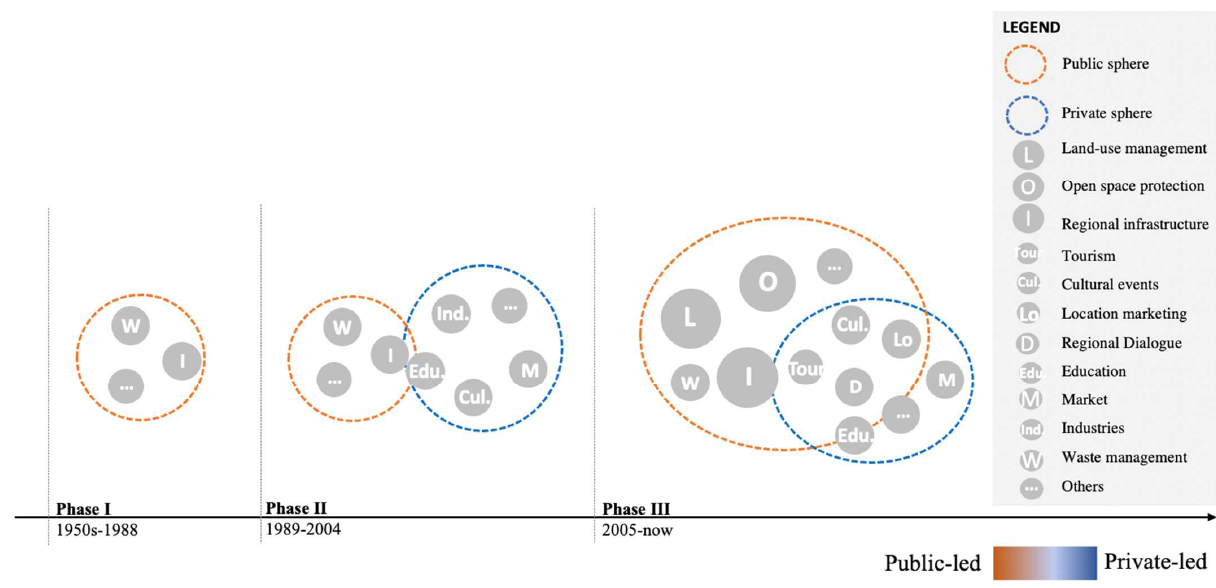
Figure 10. Changes of governance contents in the MRN. Source: the authors. Table 3. Objectives and functions of the main actors in MRN governance.